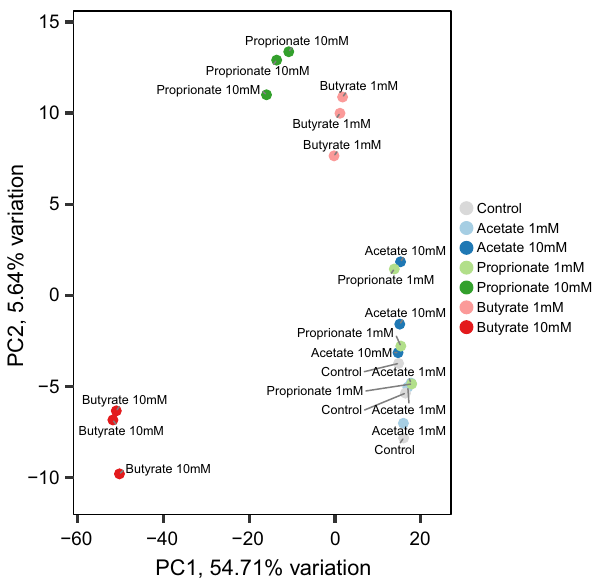
Figure 1. PCA plot of induced pluripotent stem cell derived intestinal epithelial cell layers exposed to 1 or 10 mM butyrate, propionate, acetate or control for 24